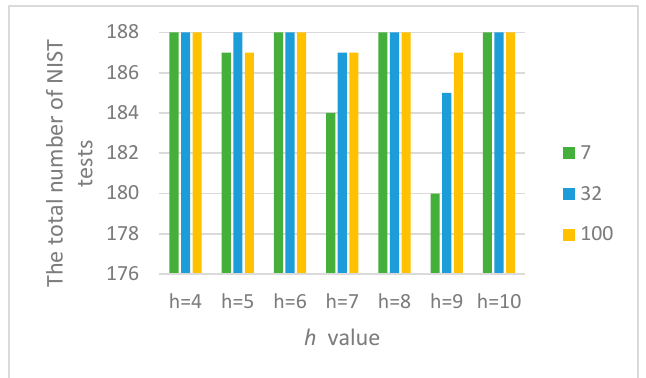
Sensors 2022 , 22 , 9700 Figure 10. Results of passing the NIST tests with the combined generator. Figure 10. Results of passing the NIST tests with the combined generator.